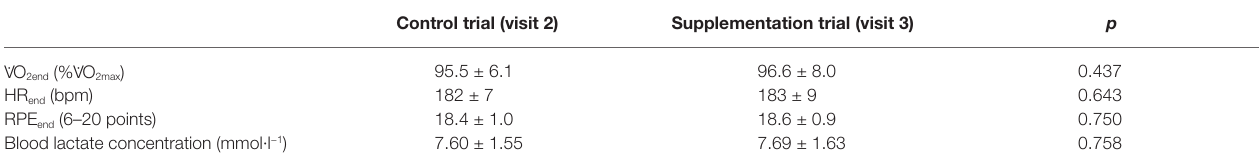
TABLE 2 | Exercise physiological parameters at the end of the standardized incremental cycling test ( n =